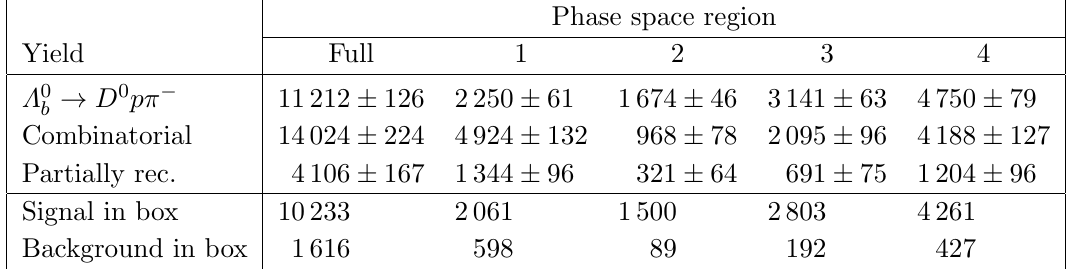
! D 0 p(cid:25) (cid:0) mass distribution in the entire (cid:3) 0 b